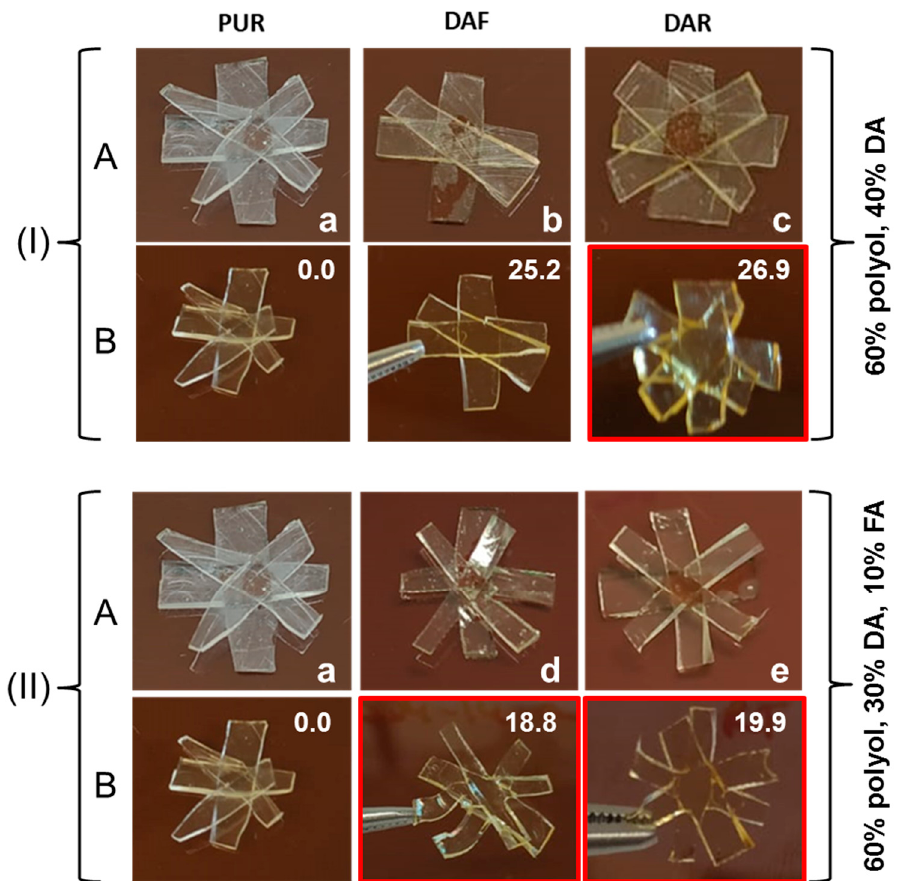
Figure 8. Photographs of adhesive samples before ( A ) and after ( B ) thermal treatment at 120 °C for 15 min. (I): ( a ) PUR-B01 reference, ( b ) PUR-B04 (25.2%TB) and ( c ) PUR-B11(26.9%TB) samples. (II): ( a ) PUR-B01 reference, ( d ) PUR-B05 (18.8%TB) and ( e ) PUR-B12 (19.9%TB) samples.